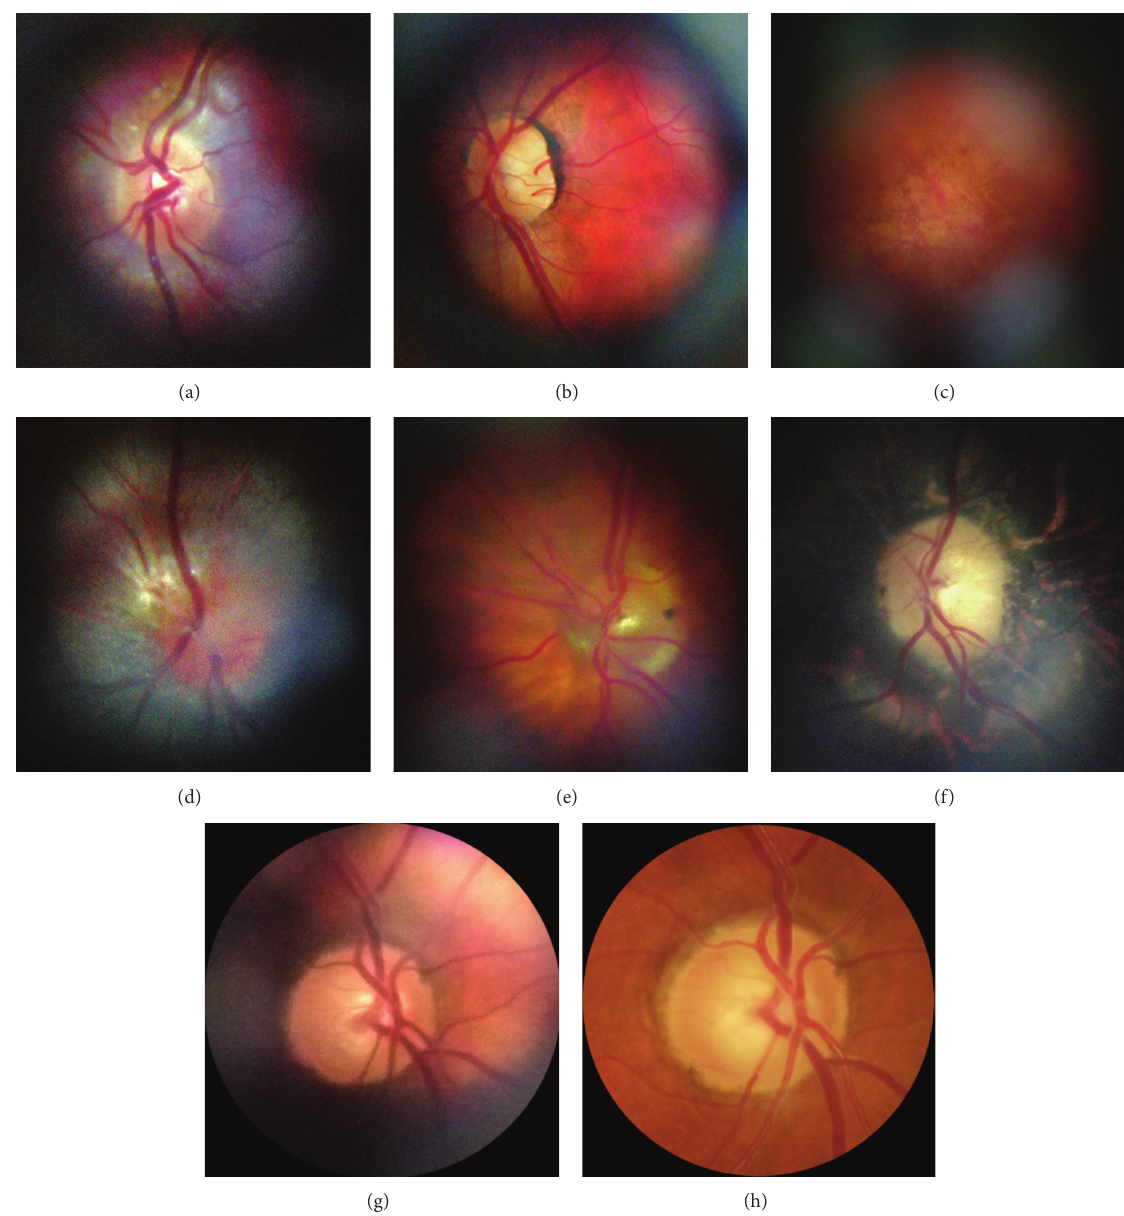
Figure 4: Representative retinal images taken with D-Eye. (a) Normal optic disc in an undilated child. (b) Normal posterior pole in a dilated 29-year-old woman. (c) Dry age-related maculopathy in an undilated 75-year-old man. (d) Optic nerve glioma in a 23-year-old undilated woman. (e) Posterior vitreous detachment in a dilated 72-year-old pseudophakic woman. (f) Waxy disc pallor and pigmentary changes in a 50-year-old man with retinitis pigmentosa. ((g) and (h)) Depiction of the same optic nerve head by D-Eye and Canon CR-2 Retinal Camera.